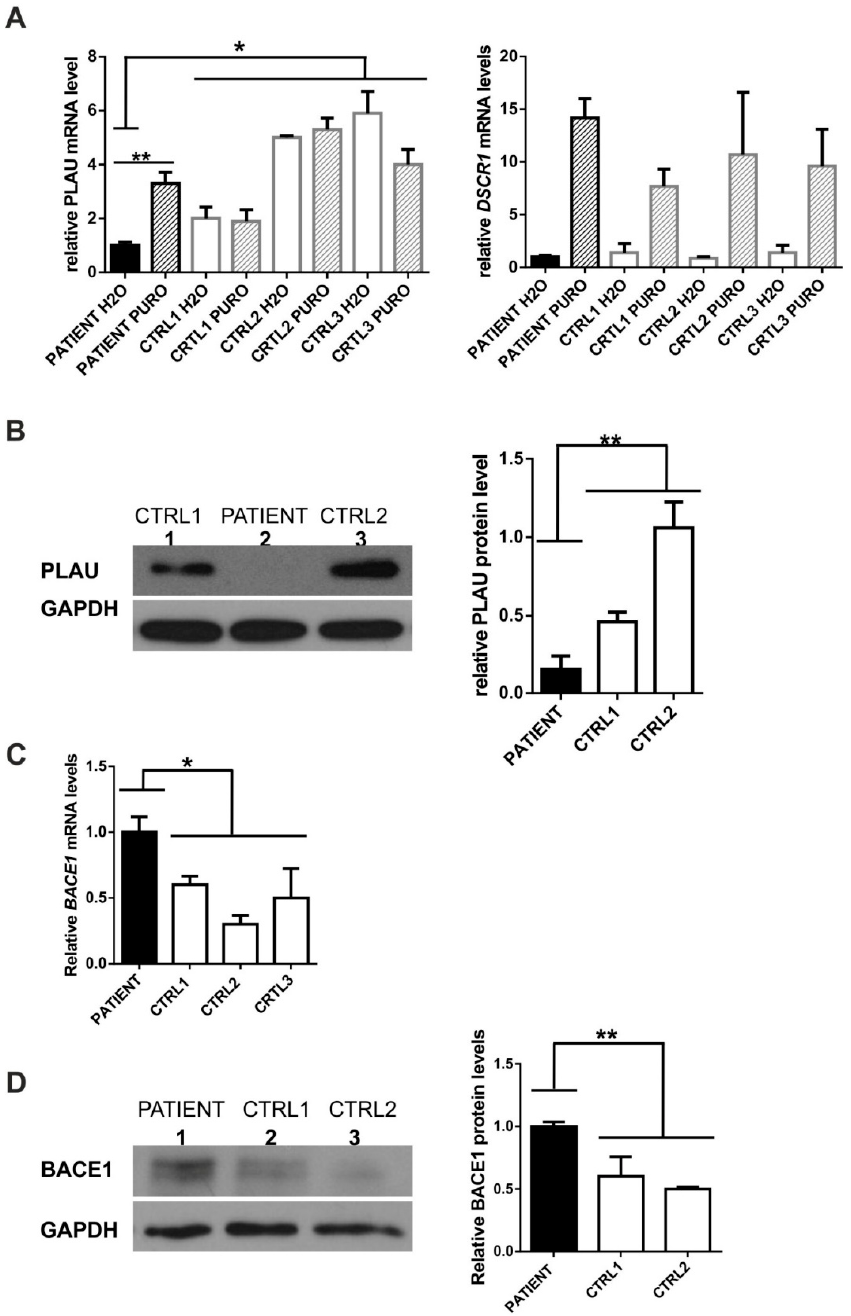
Figure 2. Functional analysis of PLAU and BACE1 variants in patients’ fibroblasts. ( A ) Decreased PLAU mRNA level in patient-derived fibroblasts (PATIENT) compared to control fibroblasts (CTRL1, CTRL2, CTRL3) could be rescued upon puromycin treatment (PURO) (left panel); As a